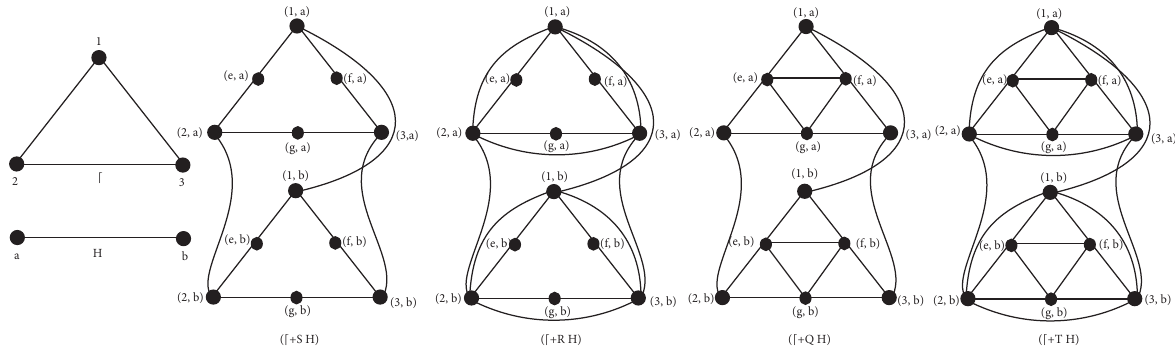
Figure 2: Graphs Γ � C